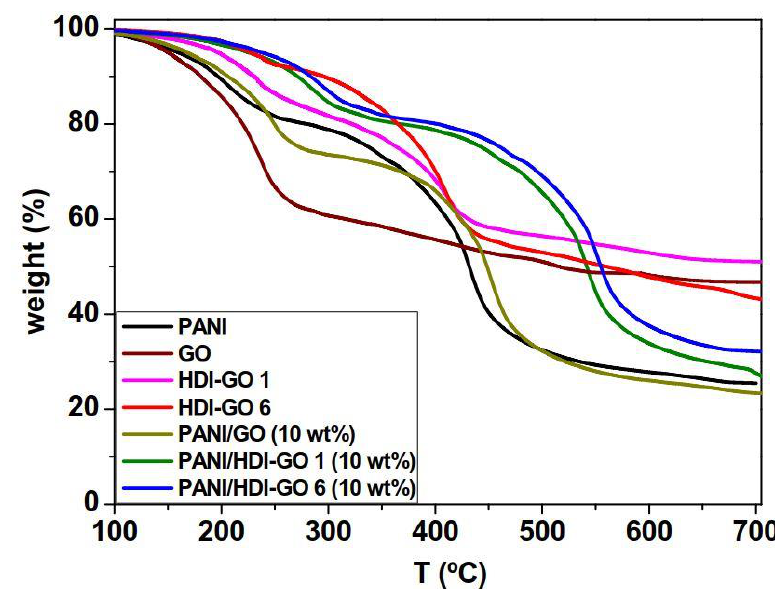
Figure 4. Thermogravimetric analysis (TGA) curves under inert atmosphere of neat PANI, GO, HDI-GO 1, HDI-GO 6, and the nanocomposites with 10 wt % nanofiller loading.